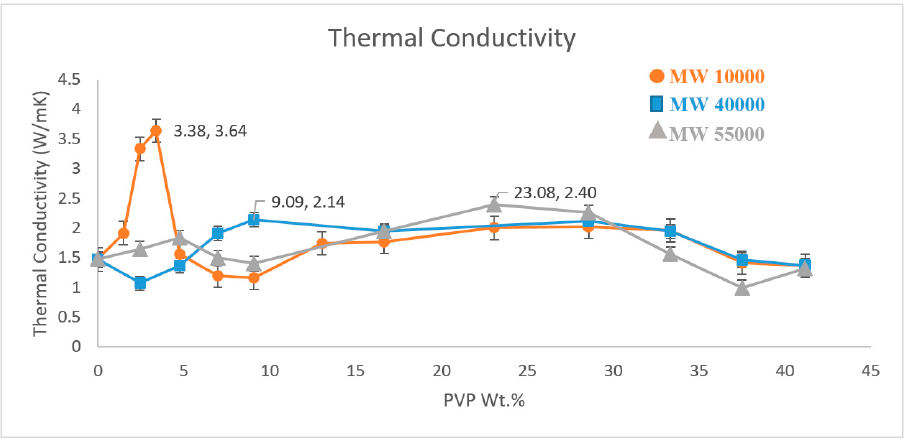
Figure 3. Thermal conductivity measure of three different PVP functionalised MWNT/PVDF composites.